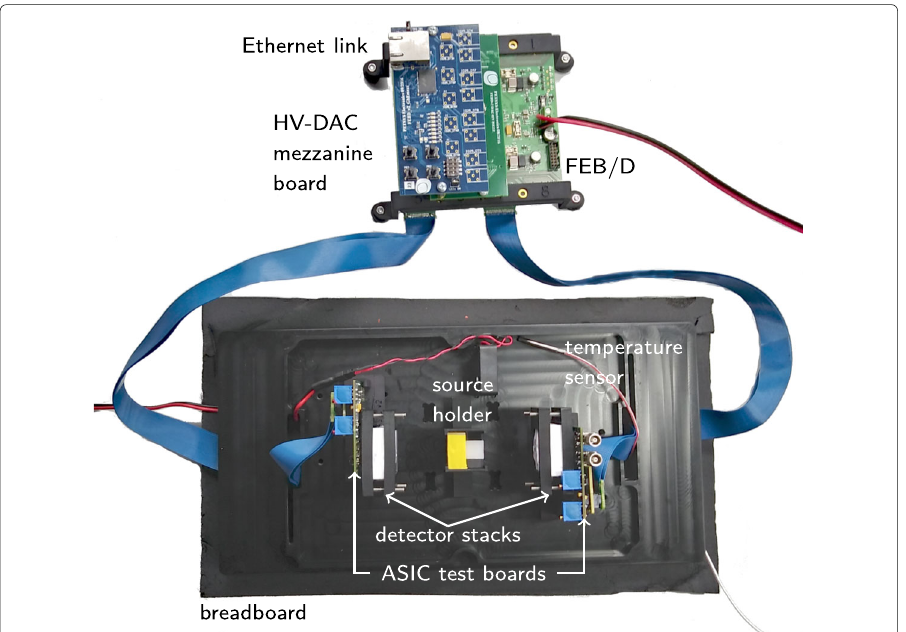
Fig. 2 Benchtop setup. Optical breadboard holding two ASIC test boards equipped with KETEK PA3325-WB-0808 SiPMs for coincidence experiments. The whole setup can be enclosed with a top cover featuring thermo-control and operated inside a climate chamber. Graphic reprinted from